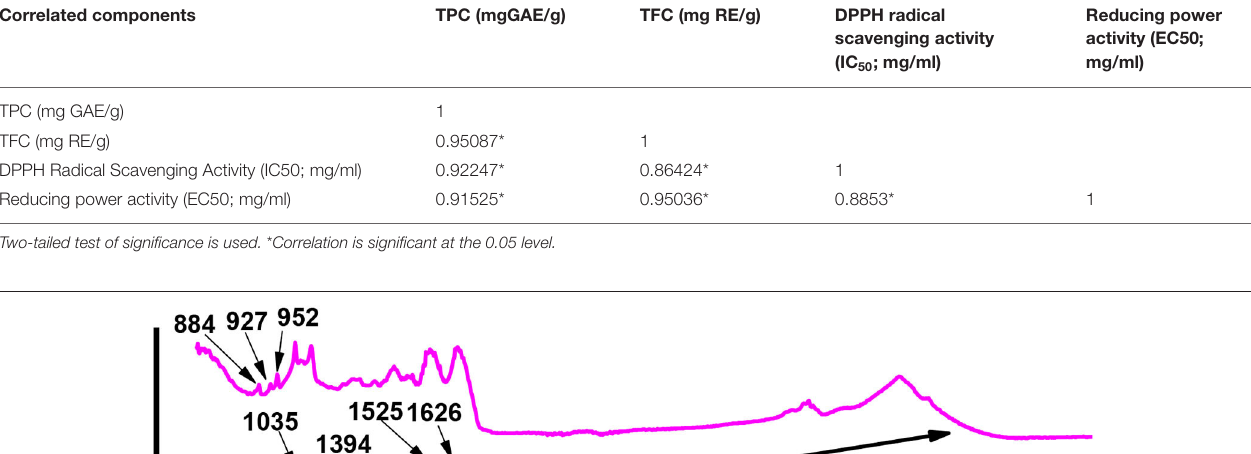
TABLE 6 | Pearson’s correlation coefficient for total phenolic content (TPC), total flavonoid content (TFC), 2,2-diphenyl-1-picrylhydrazyl (DPPH), and reducing power activity of BMP. Correlated components